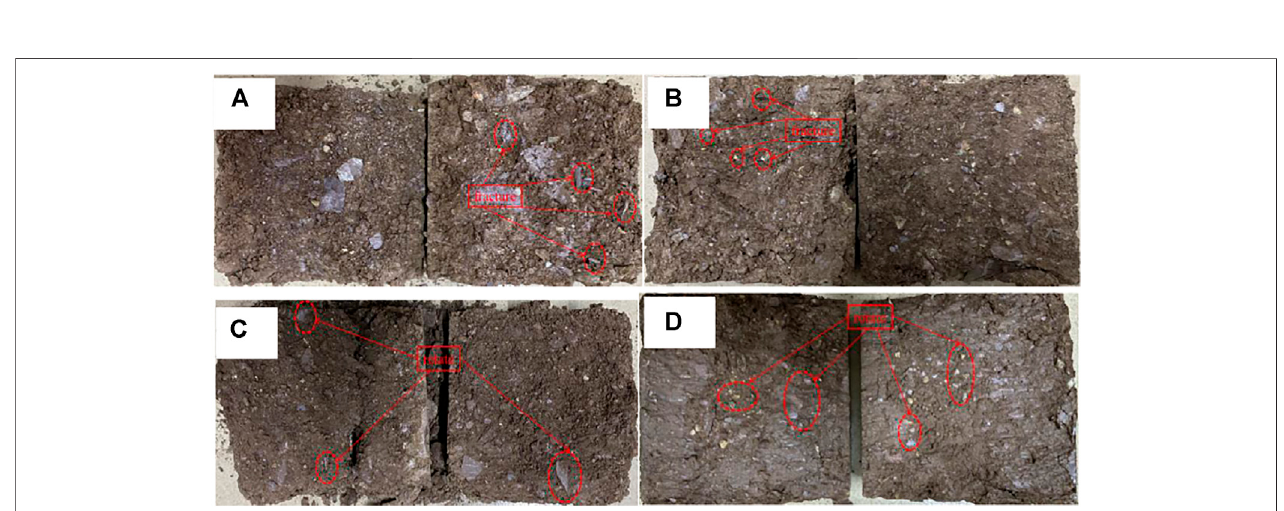
Frontiers in Physics |